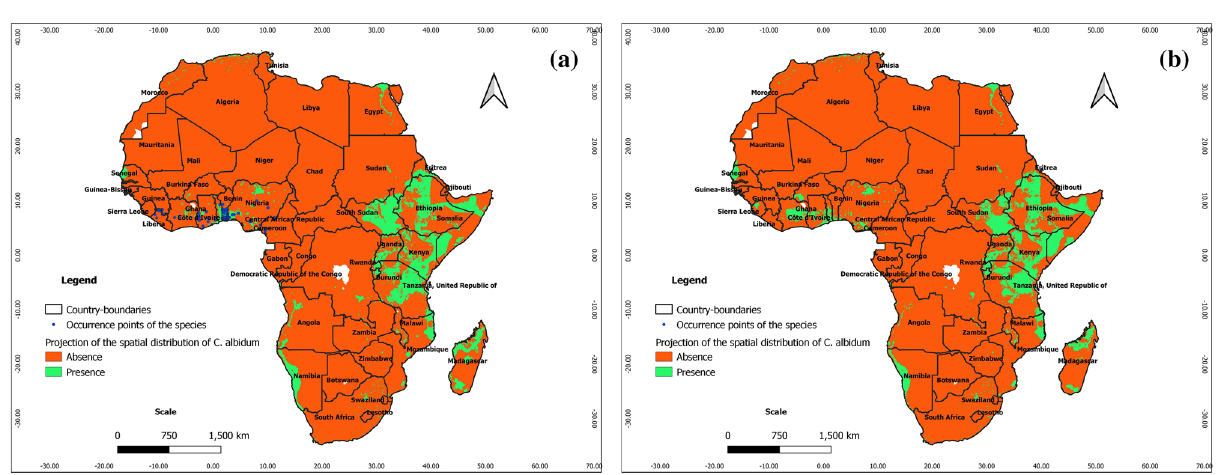
Figure 5. Projections of the spatial distribution of C . albidum according to BRT across Africa: a) at present with occurrence points; b) at horizon 2060 SSP585 (the maps were generated using R version 4.1.3 (https:// www.R- proje ct. org/), QGIS 3.18.1 (http:// qgis. osgeo. org), and WGS 84 as Coordinate Reference